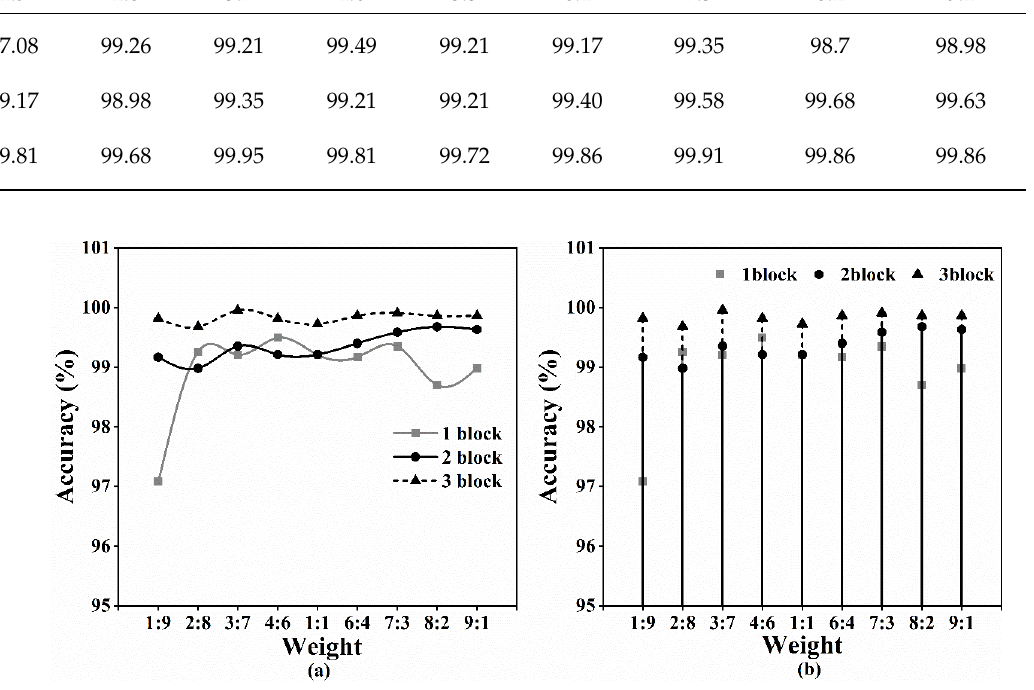
Figure 14. ( a ) Accuracy comparison of Single-block models and Multi-block models ; ( b ) Accuracy of three blocks under different weight ratios.